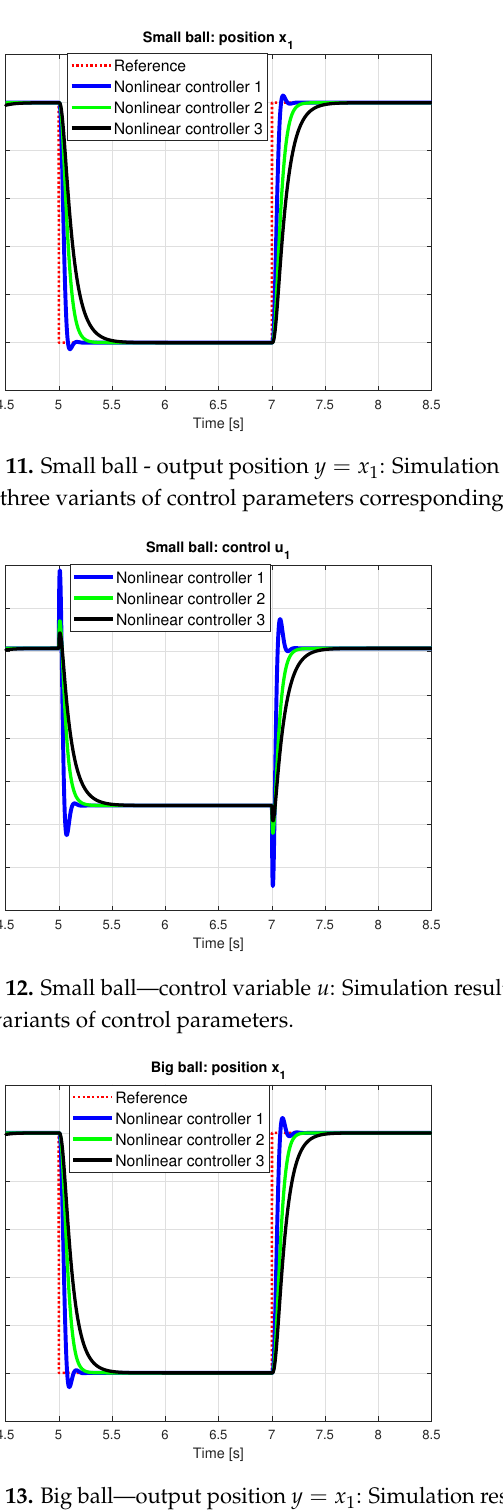
Figure 13. Big ball—output position y = x 1 : Simulation results for nonlinear control law, comparison of three variants of control parameters corresponding to the defined closed-loop